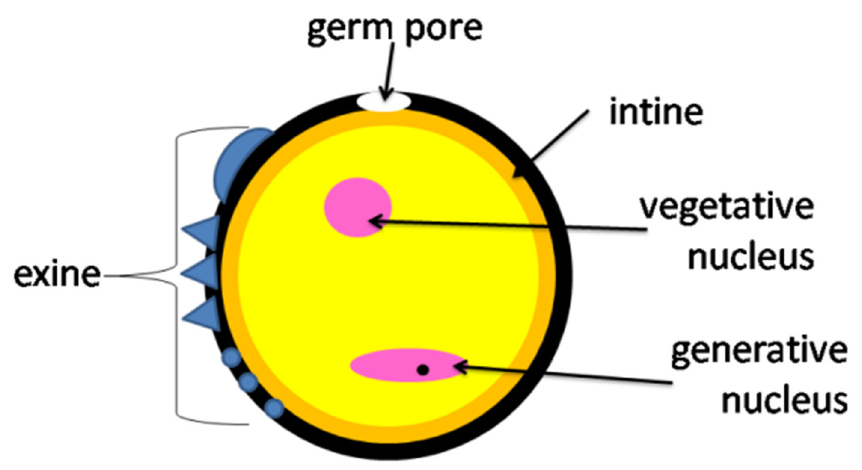
Figure 2. Structure of a pollen grain.